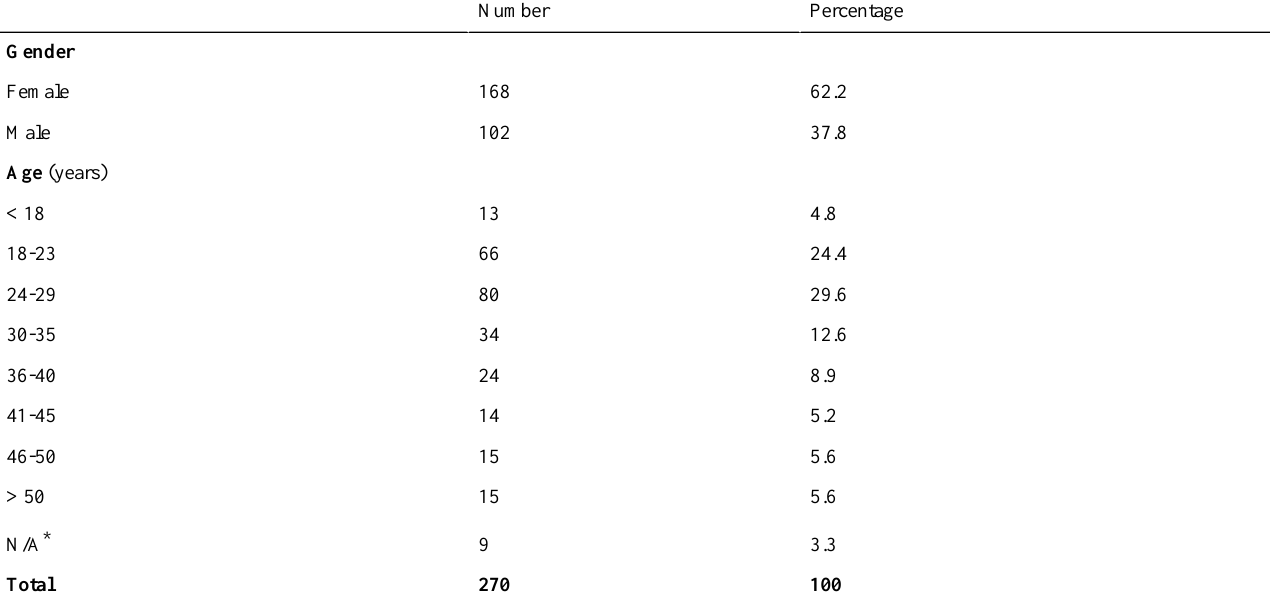
Table 1. Gender and ages of Doctor Chat